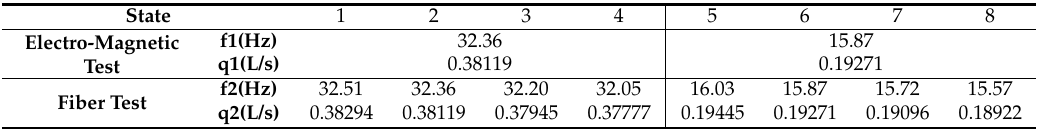
Table 5. Verification test of the fiber turbine sensor in the linear range.